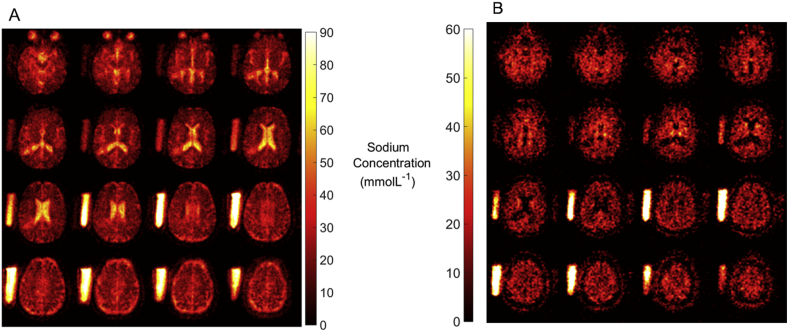
Example images of total sodium and intracellular weighted sodium in the MS brain.A) Total sodium concentration map; B) Intracellular weighted sodium concentration map.